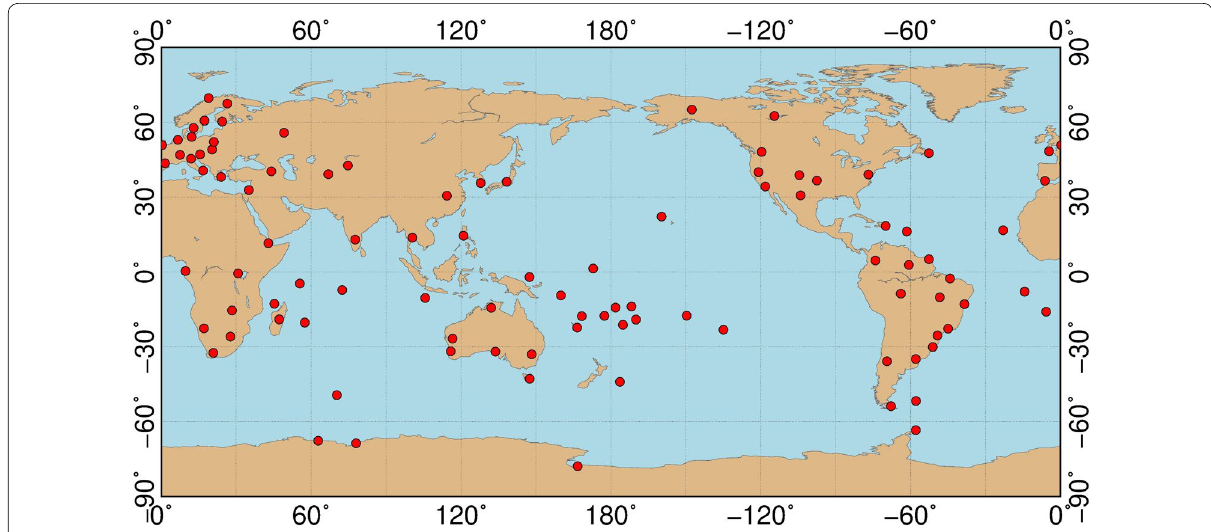
Fig. 1 Distribution of the 96 MGEX